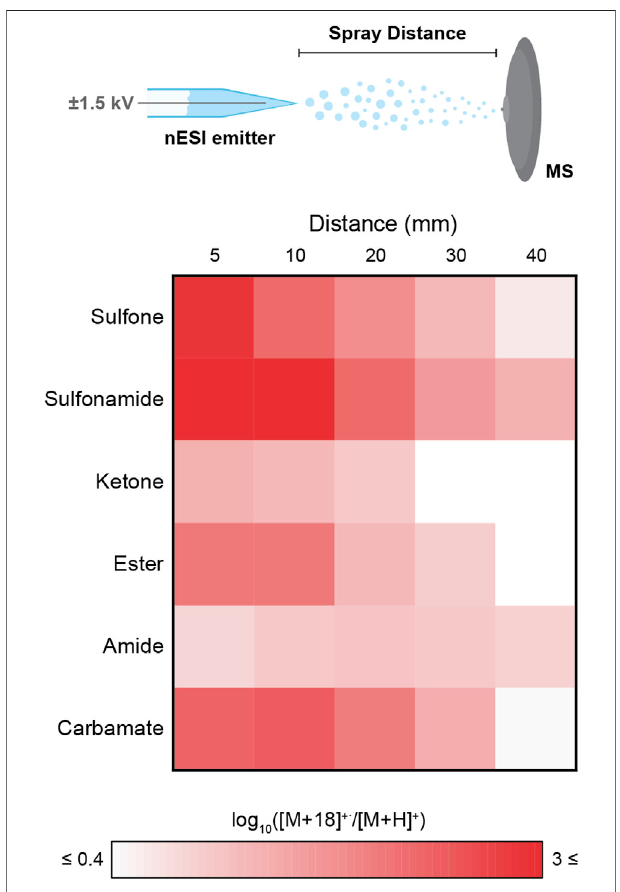
FIGURE 4 | Effect of the functional group and spray distance (i.e., distance between the nESI emitter and the mass spectrometer inlet) on the generation of [M+18] + _ , monitored as the ratio [M+18] + _ /[M+H] + . Note the color scale is logarithmic to facilitate visual comparison. Results are for six representative monofunctional compounds identi fi ed by their functional groups: sulfone (benzyl methyl sulfone, 5 ), sulfonamide (benzenesulfonamide, 6 ), ketone (2-methylbenzophenone, 7 ), ester (benzyl benzoate, 8 ), amide (benzamide, 9 ), and carbamate (benzyl carbamate, 10